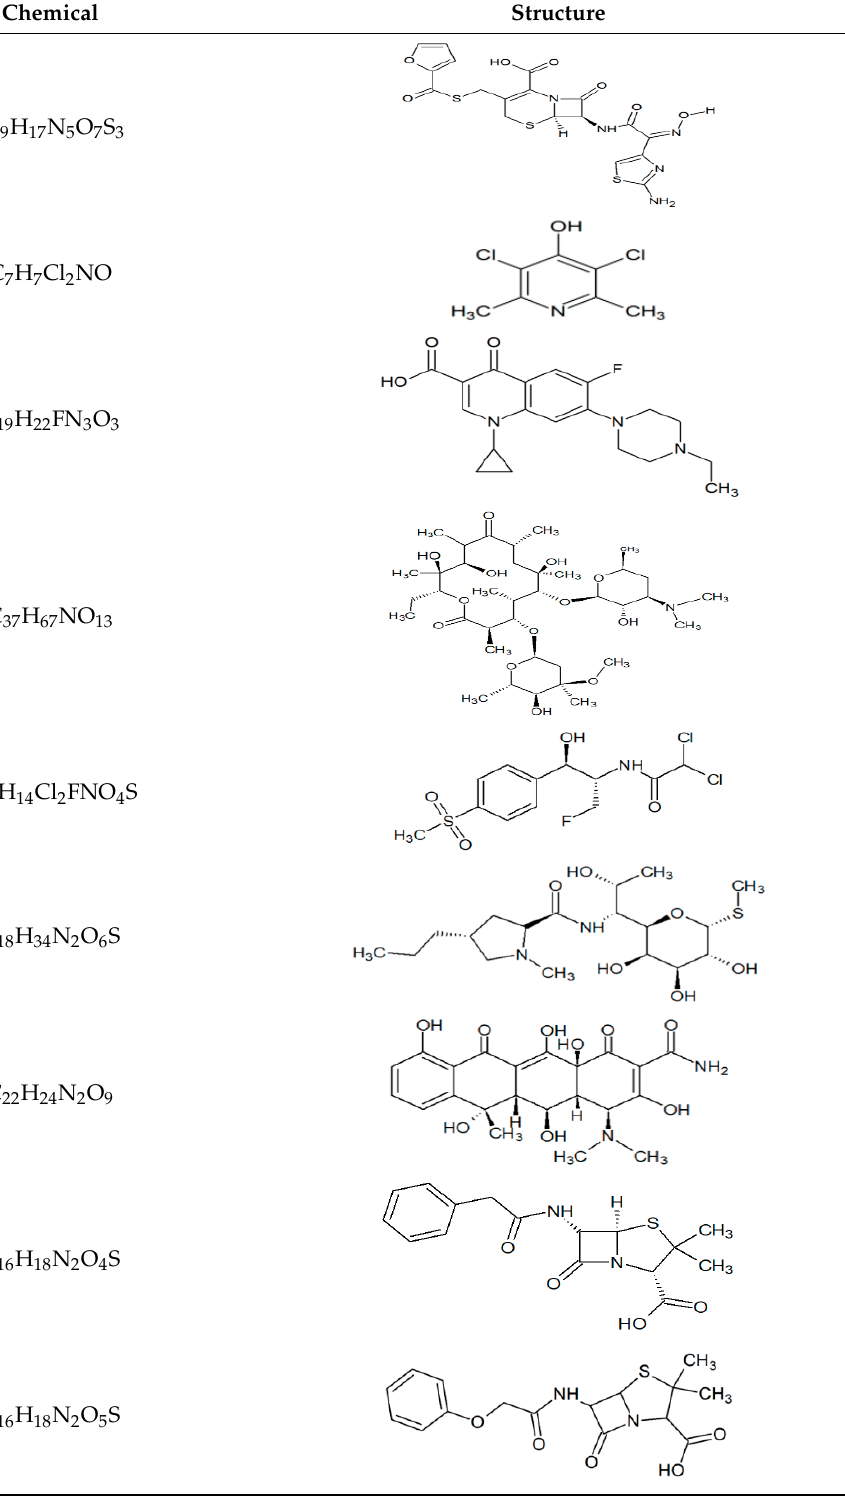
Table 1. Chemical formula and molecular structure of the antibiotics.